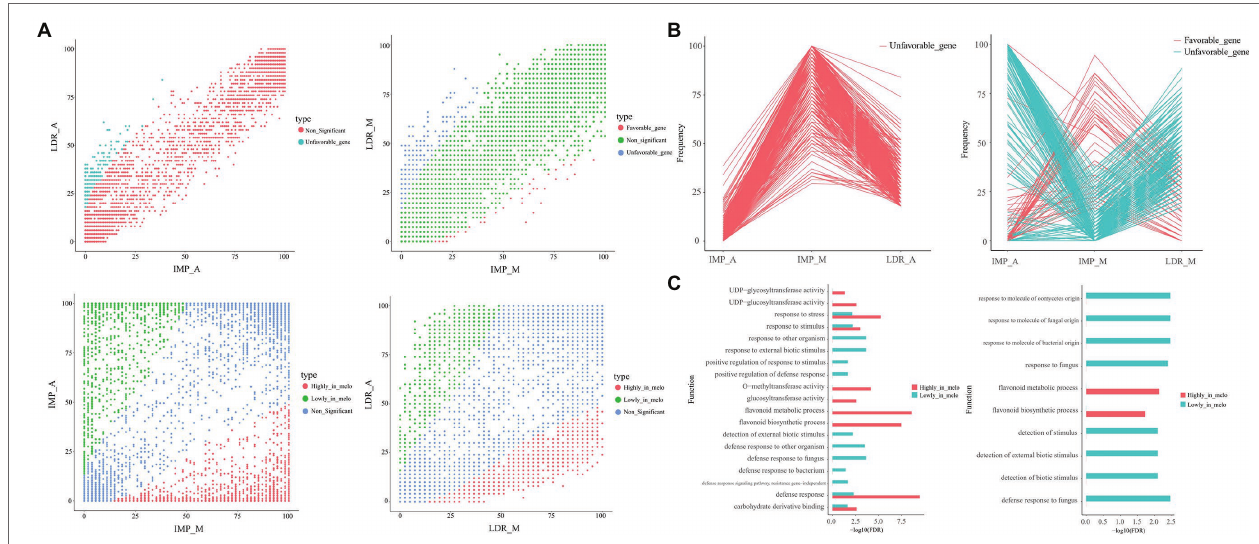
FIGURE 2 | The difference in the frequencies of the selected genes. (A) Scatter plots showing gene occurrence frequencies in IMP_A, LDR_A, IMP_M, and LDR_M. The comparison groups include IMP_A vs. LDR_A, IMP_M vs. LDR_M, IMP_M vs. LDR_A, and LDR_M vs. LDR_A. (B) Occurrence frequency patterns of favorable and unfavorable genes during improvement. (C) Enriched GO terms (FDR < 0.05) in the selected genes of IMP_M vs. IMP_A (left) and IMP_A vs. LDR_A